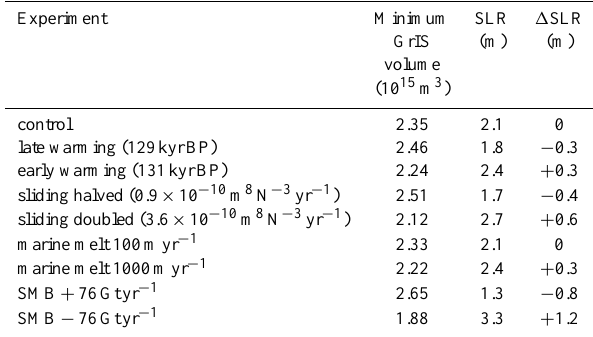
Table 3. Summary of sensitivity experiments. Each experiment was carried out with one perturbed parameter. Resulting minimum ice volume and associated SLR are